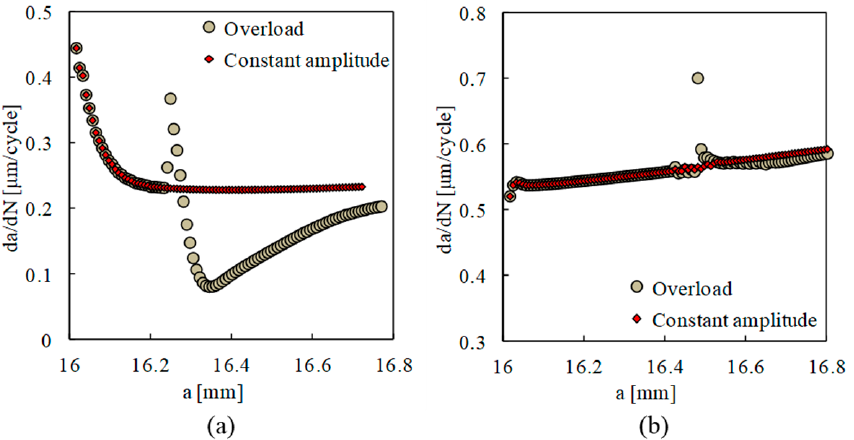
Figure 12. E ff ect of an overload on da / dN . ( a ) With contact of crack flanks. ( b ) Without contact of crack flanks ( F max = 41.67 N; F min = 4.17 N; F OL = 60.42 N; ∆ K BL = 10.3 MPa · m 0.5 ; OLR = 1.5).